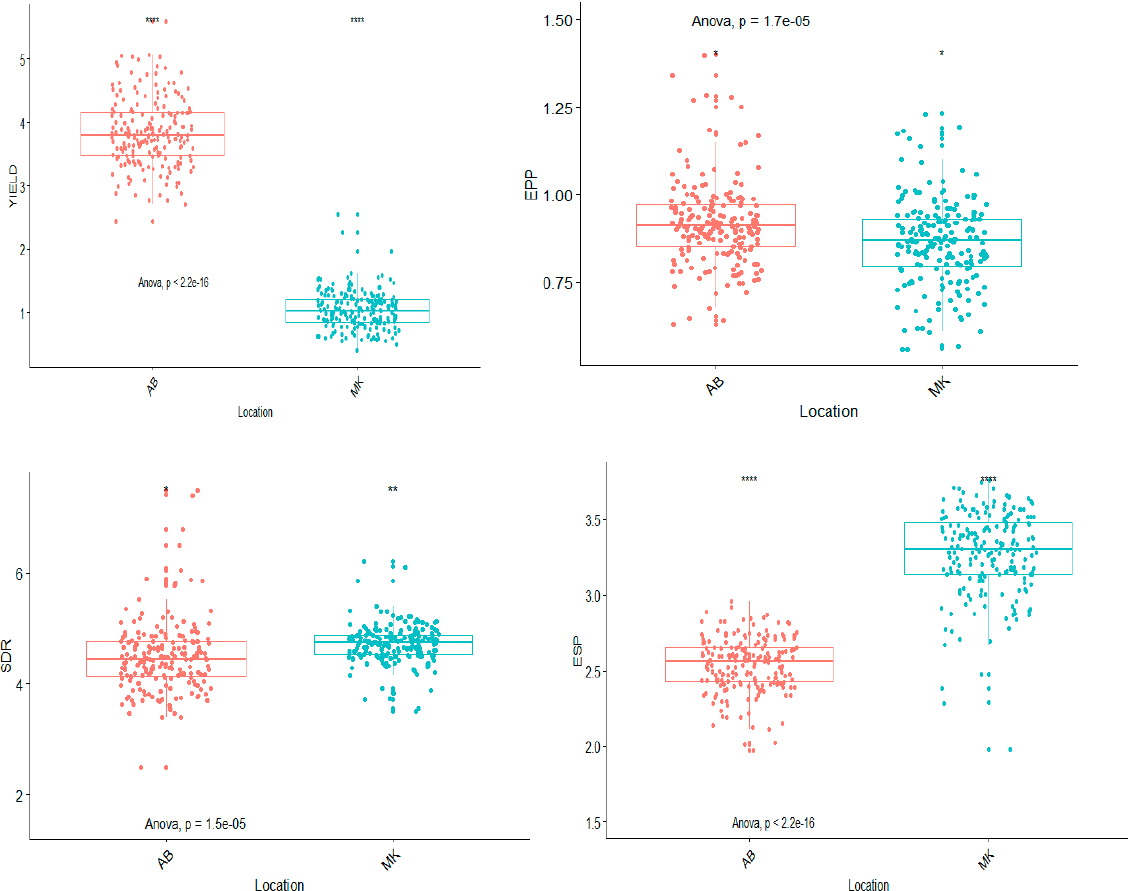
Figure 1. Box plots showing the distribution of ( A ) grain yield (YIELD, t / ha), ( B ) emerged Striga plants (ESP), ( C ) Striga damage rating (SDR) and ( D ) number of ears per plant (EPP) under artificial Striga infestation at Mokwa (MK) and Abuja (AB) in 2018. The points represent the F 2:3 families and the parental genotypes. Table 1. Descriptive statistics of Striga resistance indicator traits of parents and F 2:3 population derived from the cross between TZEEI 79 × TZdEEI 11 across Striga -infested environments. Striga Grain Yield, kg / ha Ears per Plant Striga Damage Count